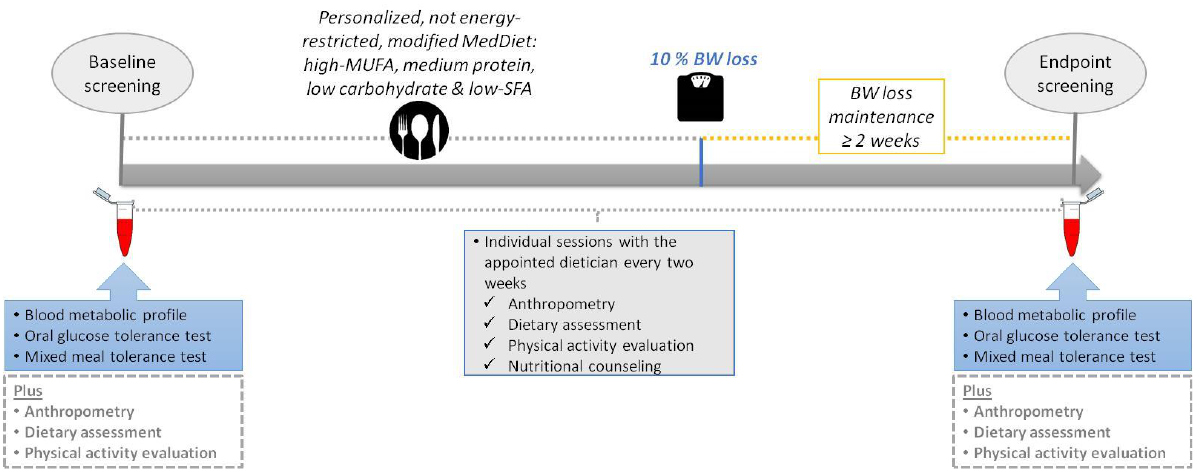
Figure 1. Study design.BW, body weight; MUFA, monounsaturated fatty acid; SFA, saturated fatty acid.